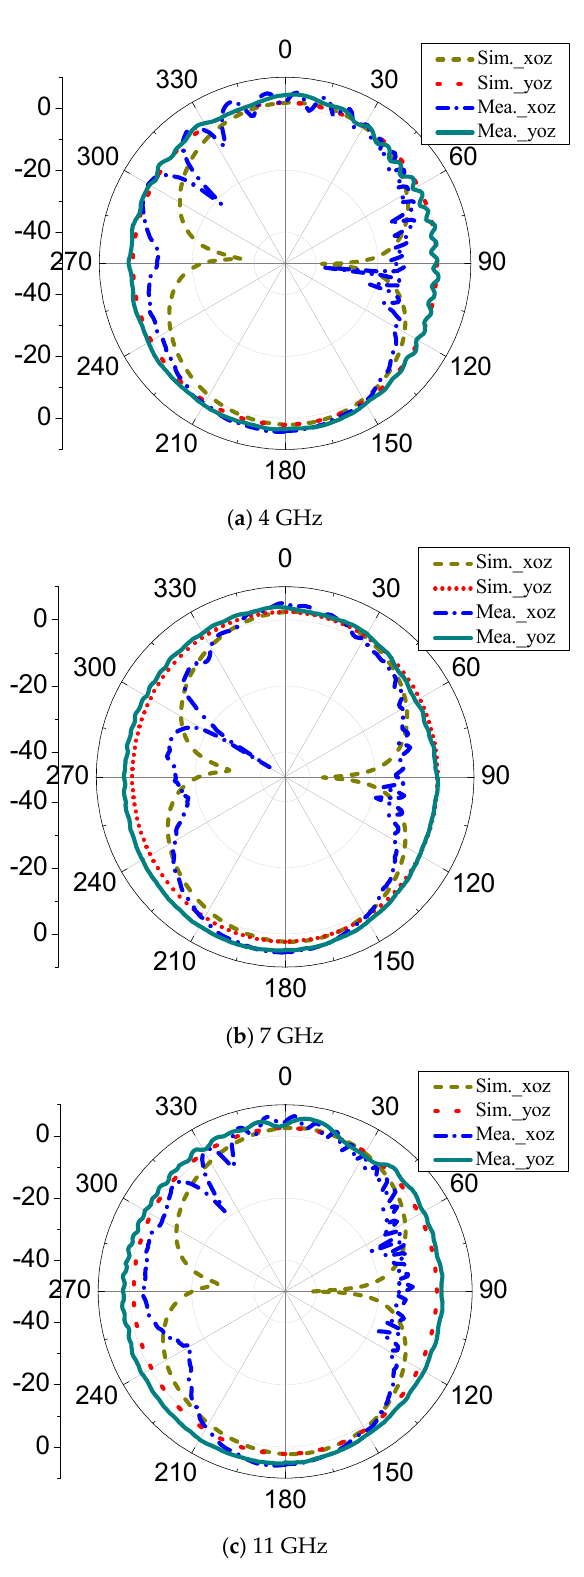
Figure 15. Simulation and measurement radiated pattern on xoz plane and yoz plane, respectively. ( a ) 4 GHz, ( b ) 7 GHz, ( c ) 11 GHz.